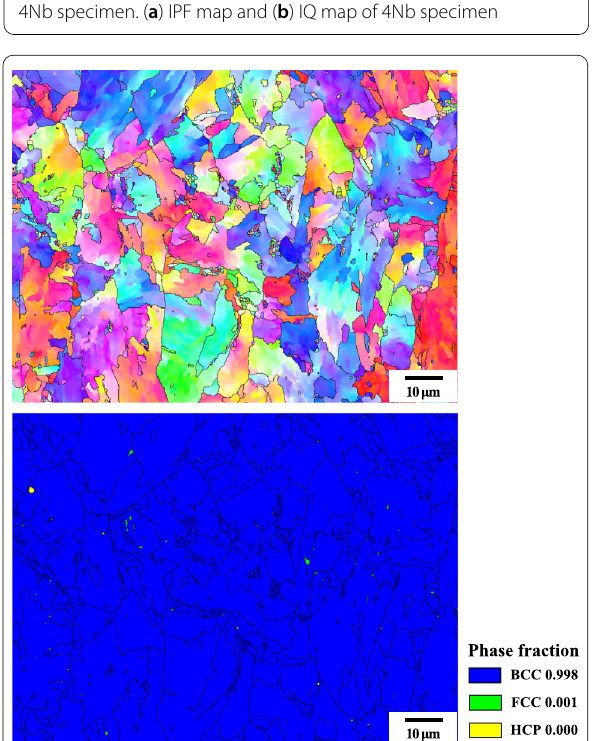
Fig. 11 Phase map analysis subjected to Final LePera etching conditions of 4Nb specimen. Almost fully bcc phase was observed